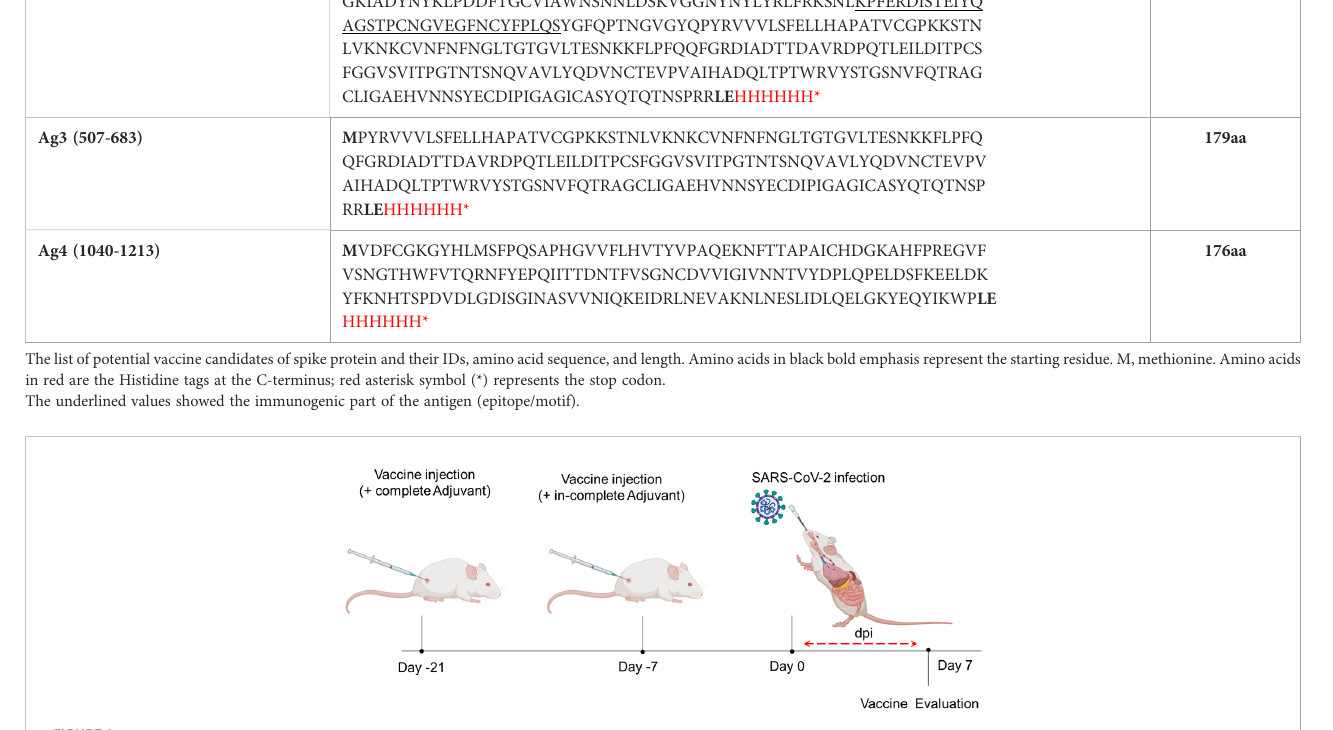
FIGURE 1 Schematic drawing showing the experimental design of the vaccination. K18-hACE2 TG mice were injected twice with 2 m g or either vaccine A or vaccine B subcutaneously at intervals of 2 weeks. After a week of a second injection, mice were infected with SARS-CoV-2 (10 5 PFU) through the intranasal route, and 7 days postinfection changes were assessed.